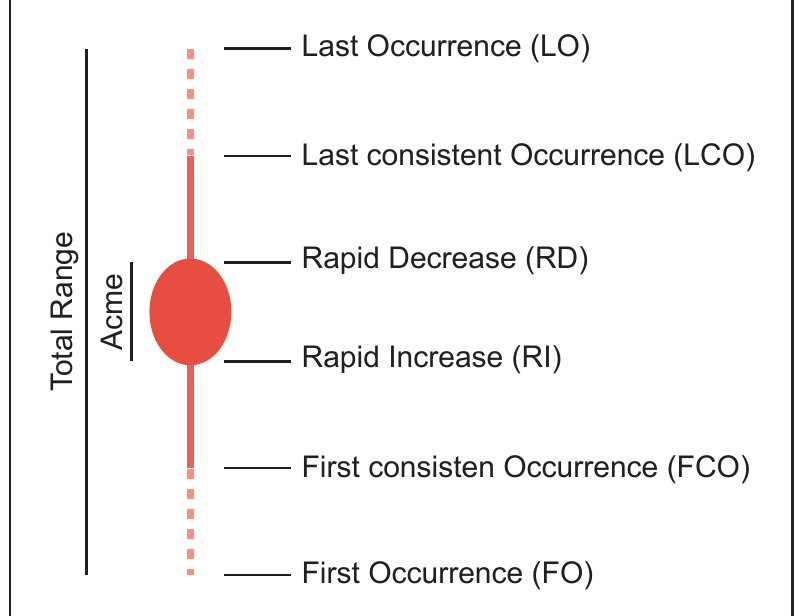
Figure 1. Terminology of biostratigraphic events along the total stratigraphic range of a single taxon. The first and last consistent occurrence may coincide with the first and last common occurrence; the rapid increase and rapid decrease encapsulate the acme of the taxon. Instead of First or Last Occurrence, First or Last Appearance is frequently used. The former is a chronostratigraphic term, and the latter a geochronologic